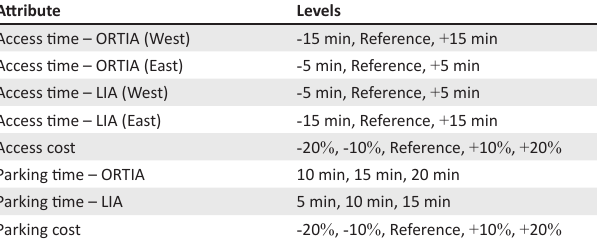
TABLE 1: Description of the stated choice experiment levels.